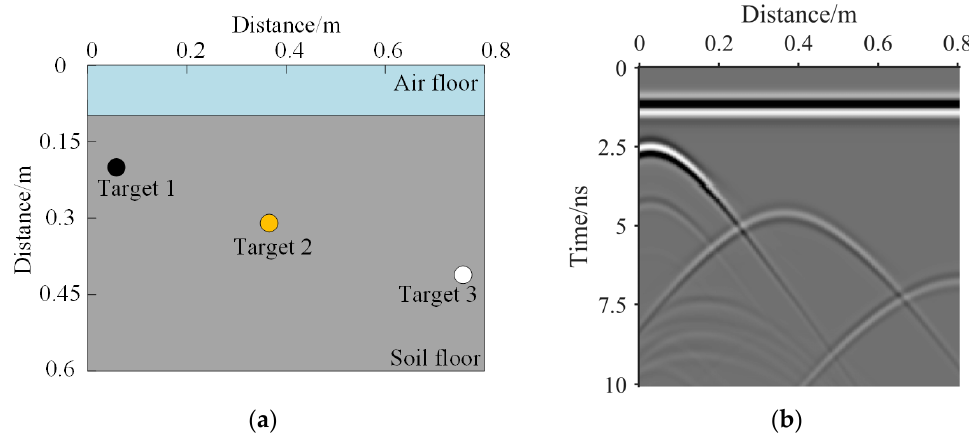
Figure 6. ( a ) GPRmax simulation model 2. ( b ) Simulated noise-free GPR image 2. To simulate the random noise in real GPR images, time-varying Gaussian noise is added to the simulated noise-free GPR images. The curve of time-varying Gaussian noise is shown in Figure 7.